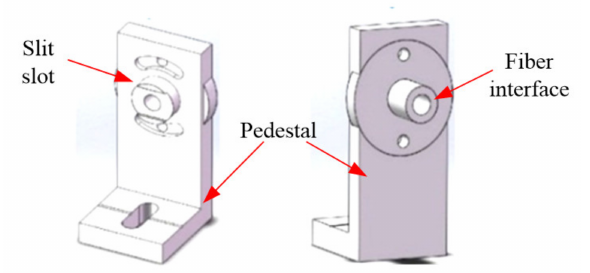
Figure 16. The components of the optical fiber and entrance slit.